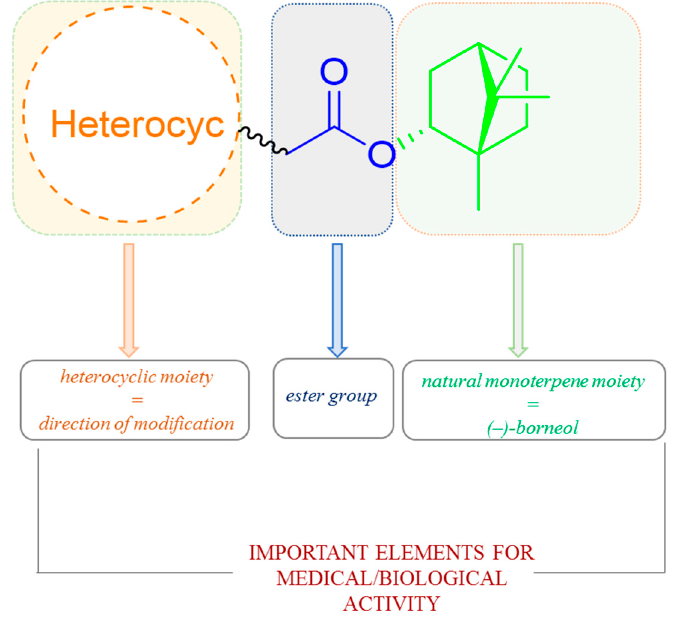
Figure 37. The design strategy for heterocyclic (–)-borneol-based esters with the effectiveness of the biological activity.